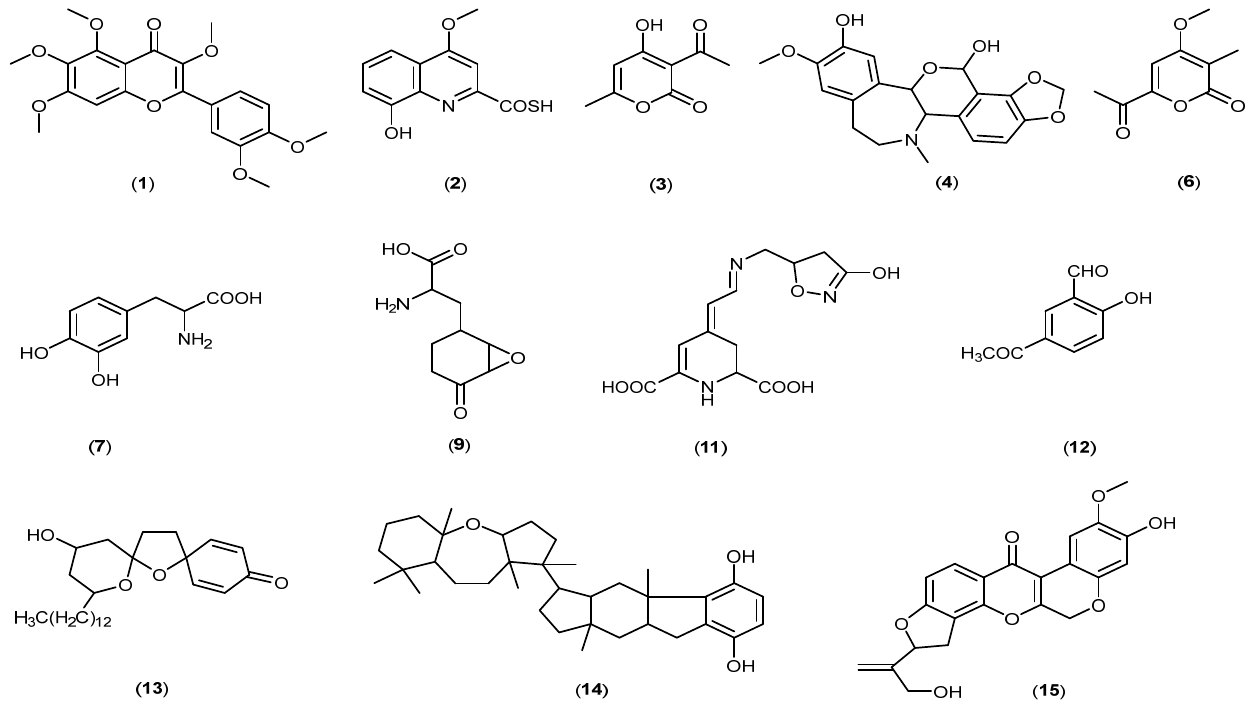
Figure 10. Chemical structures of discriminant putatively identified metabolites in DFC and DFS.